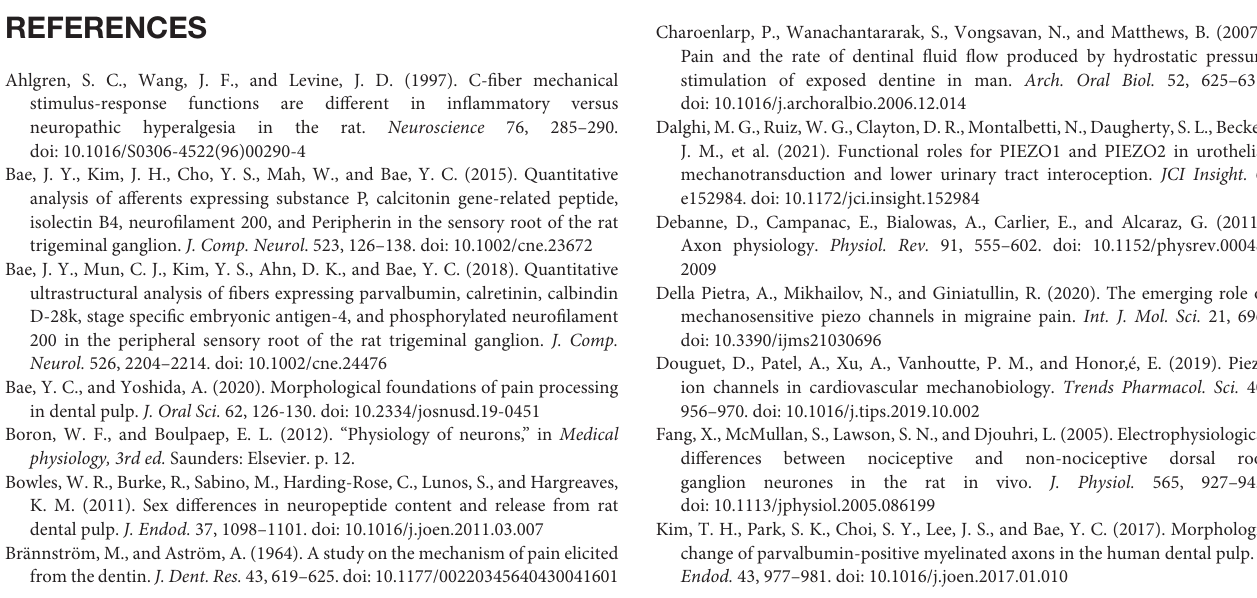
FIGURE 4 | of all Piezo1 + axons in each region of the human dental pulp (D) , and an electron micrograph of myelinated axon showing shedding of its myelin sheath during its course in the rat dental pulp [ (E) , modified from Bae and Yoshida, 2020]. Piezo1 + myelinated axons are more frequent in the radicular pulp than in the core of the coronal pulp, and virtually all Piezo1 + axons are unmyelinated in the peripheral pulp, suggesting that most Piezo1 + myelinated axons in the radicular pulp lose their myelin and become unmyelinated in the peripheral pulp. This assumption can be supported by our previous study showing the shedding of myelin sheath from myelinated axon within the rat dental pulp (E) . Asterisks in (D) indicate significant differences ( p < 0.05) among the fraction of Piezo1 + small myelinated or unmyelinated axons in each of the three regions of human dental pulp. Arrowheads in (A–C) indicate immunoreaction product of Piezo1. Arrowheads in (E) indicate unmyelinated portion of the myelinated axon (asterisk). Scale bar = 1 µ